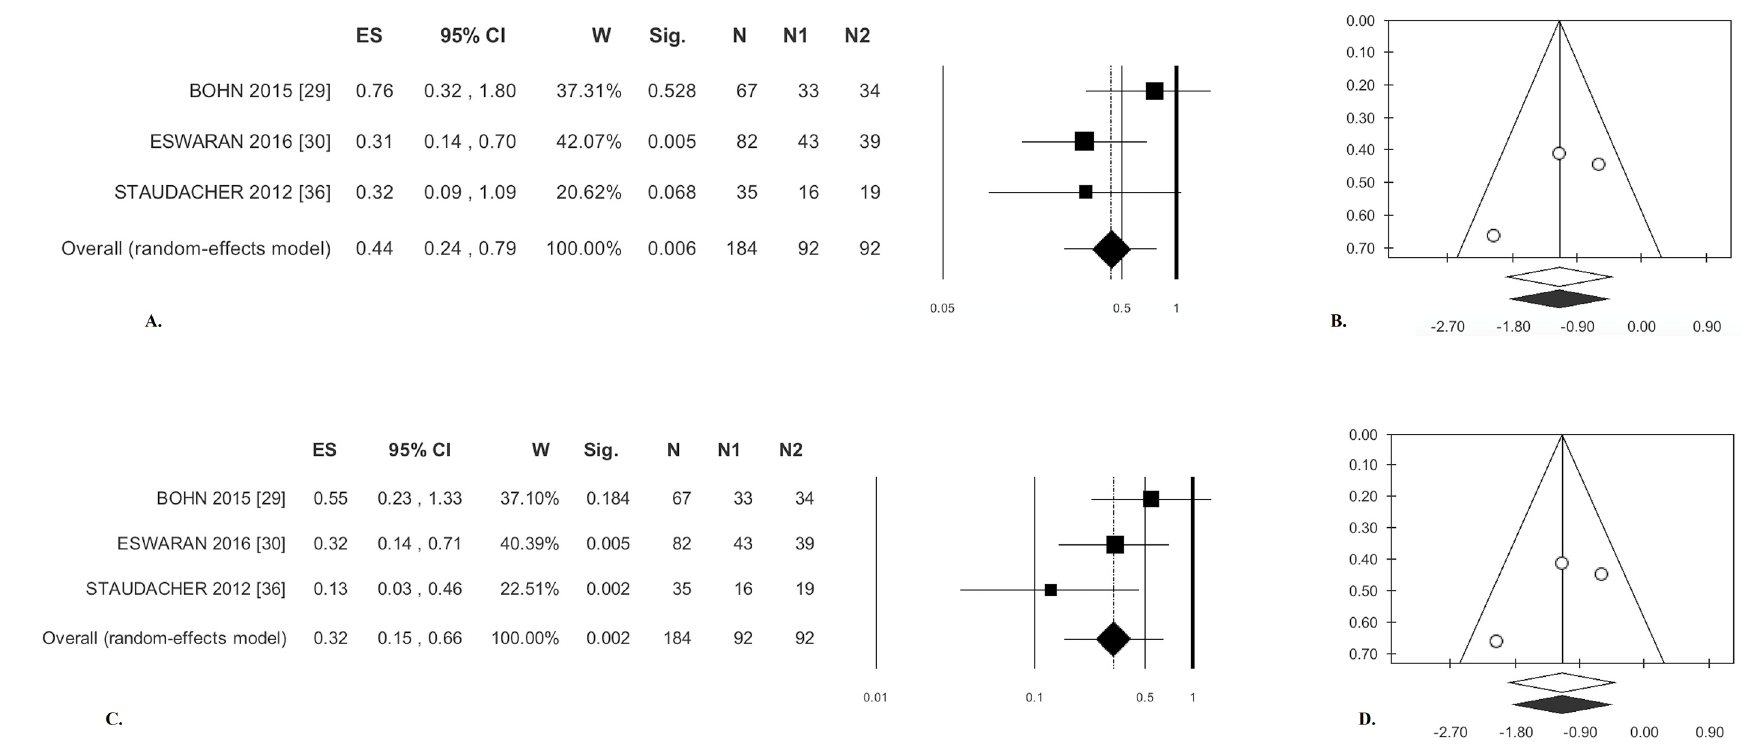
Figure 2. Low ‐ FODMAP diet versus traditional IBS diet. Abdominal pain: ( A ) forest plot and ( B ) funnel plot. Bloating: ( C ) forest plot and ( D ) funnel plot.